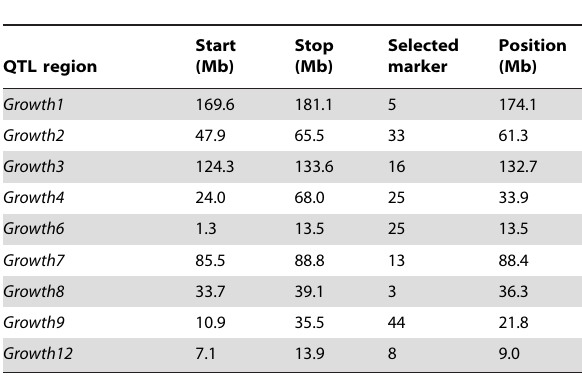
Table 1. Marker locations with the strongest interactions in the nine tested chromosomal